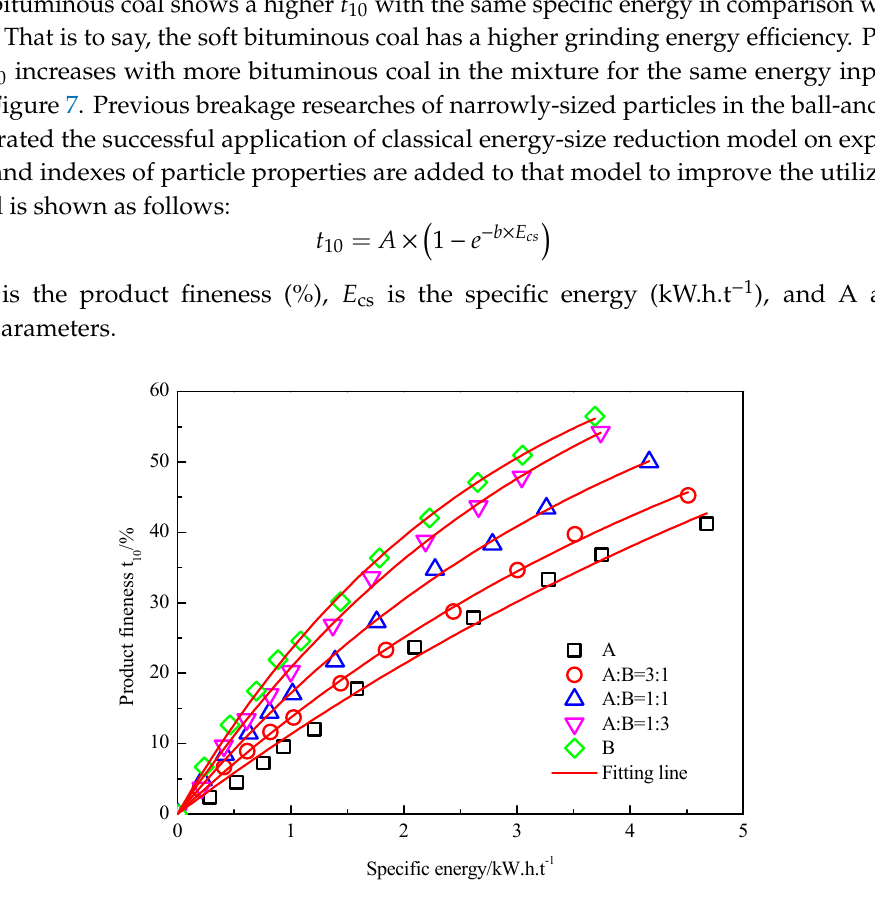
Figure 7. Specific energy vs product fineness t 10 of mixtures. Table 2. Breakage parameters of mixtures.